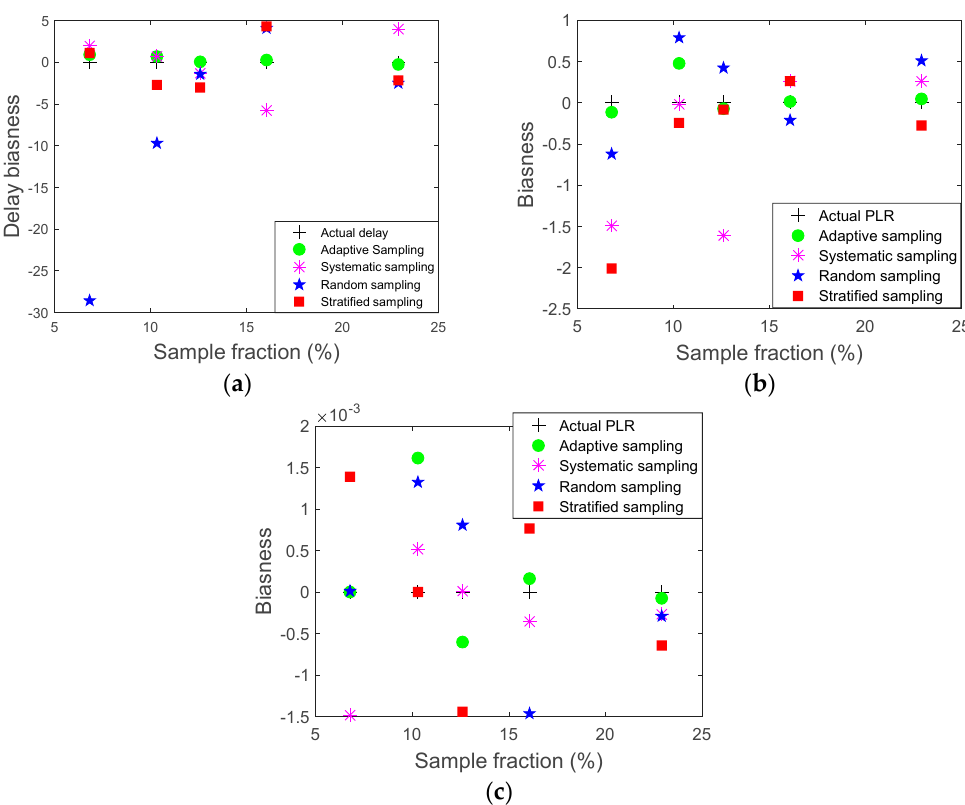
Figure 10. Comparisons of biasness of ( a ) delay, ( b ) jitter, and ( c ) %PLR between the developed technique and nonadaptive methods.